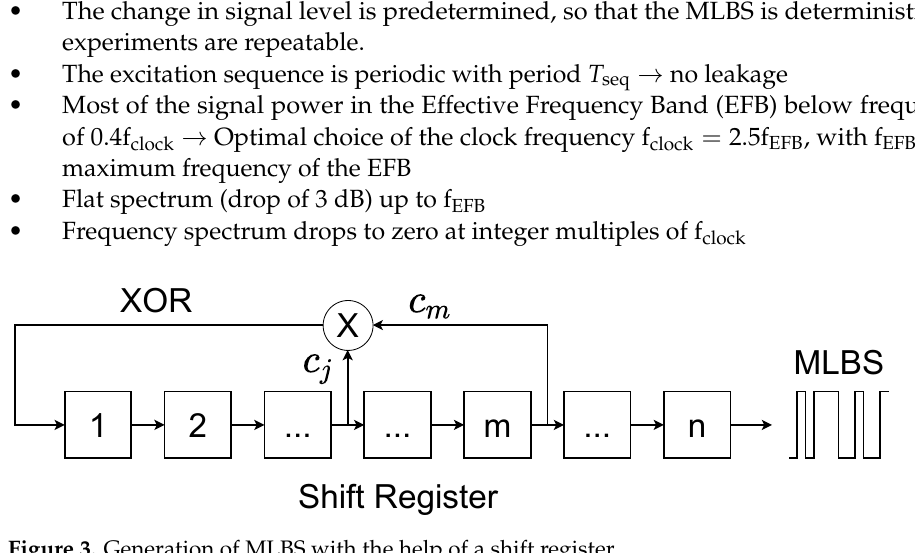
Figure 3. Generation of MLBS with the help of a shift register.